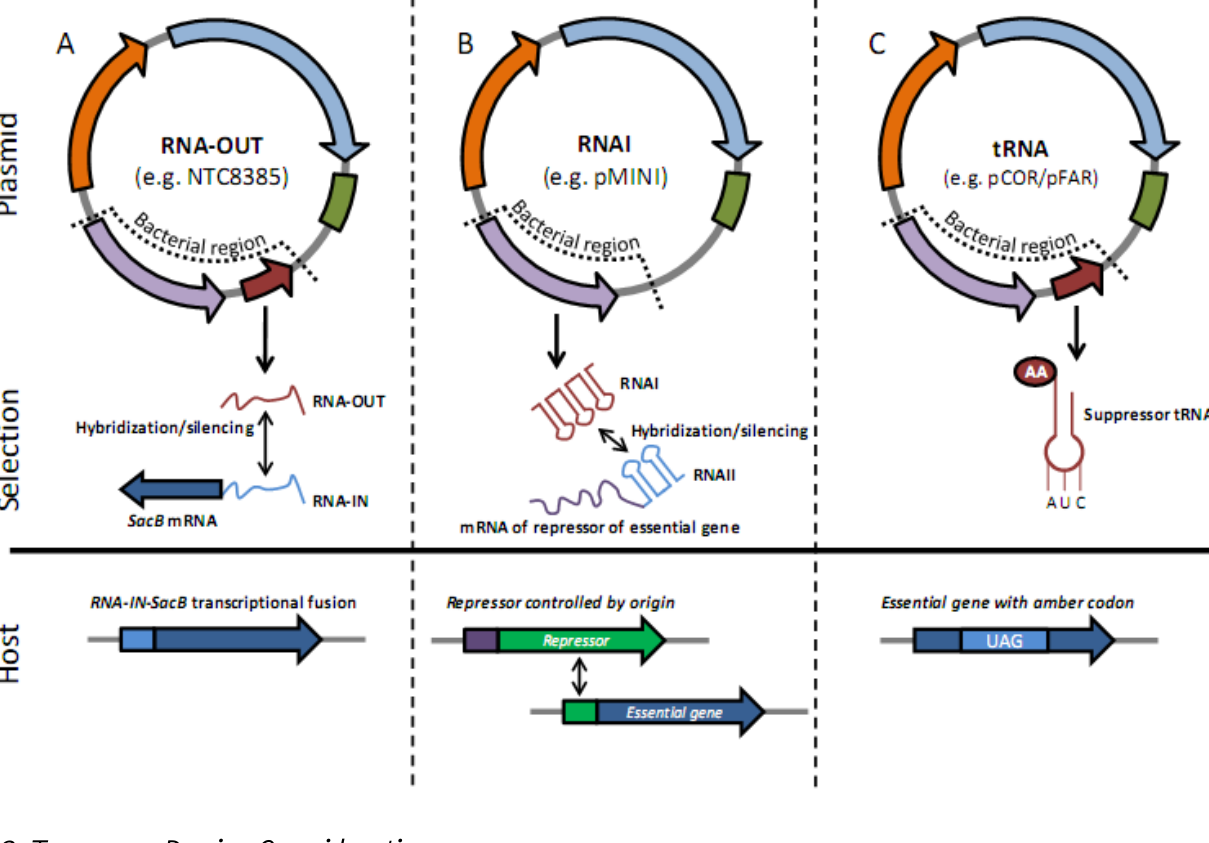
Figure 3. RNA selectable marker DNA vaccine plasmids. Purple arrow in bacterial region is pUC replication origin, brown arrow in panels ( a ) and ( c ) is the RNA selection marker. Eukaryotic region promoter, transgene and polyA are depicted with orange arrow, blue arrow and green box, respectively. ( a ) NTC8385 plasmid borne RNA-OUT RNA binds a chromosomally encoded constitutively expressed mRNA that contains the RNA-IN target sequence in the leader. This prevents translation of the downstream levansucrase (sacB), allowing growth on sucrose media; ( b ) pMINI pUC origin encoded RNAI binds a chromosomally encoded constitutively expressed mRNA that contains the RNAII target sequence in the leader. In the murselect -system, an essential gene ( murA ) is modified to contain a repressor binding site in the promoter and the RNAII target sequence is incorporated into the repressor mRNA leader. RNAI binding to RNAII prevents repressor translation, allowing expression of the essential gene; ( c ) pFAR4/pCOR plasmid borne suppressor tRNA allows read-through translation of an amber nonsense codon in a chromosome encoded essential gene. Adapted from Oliveira and Mairhofer, 2013